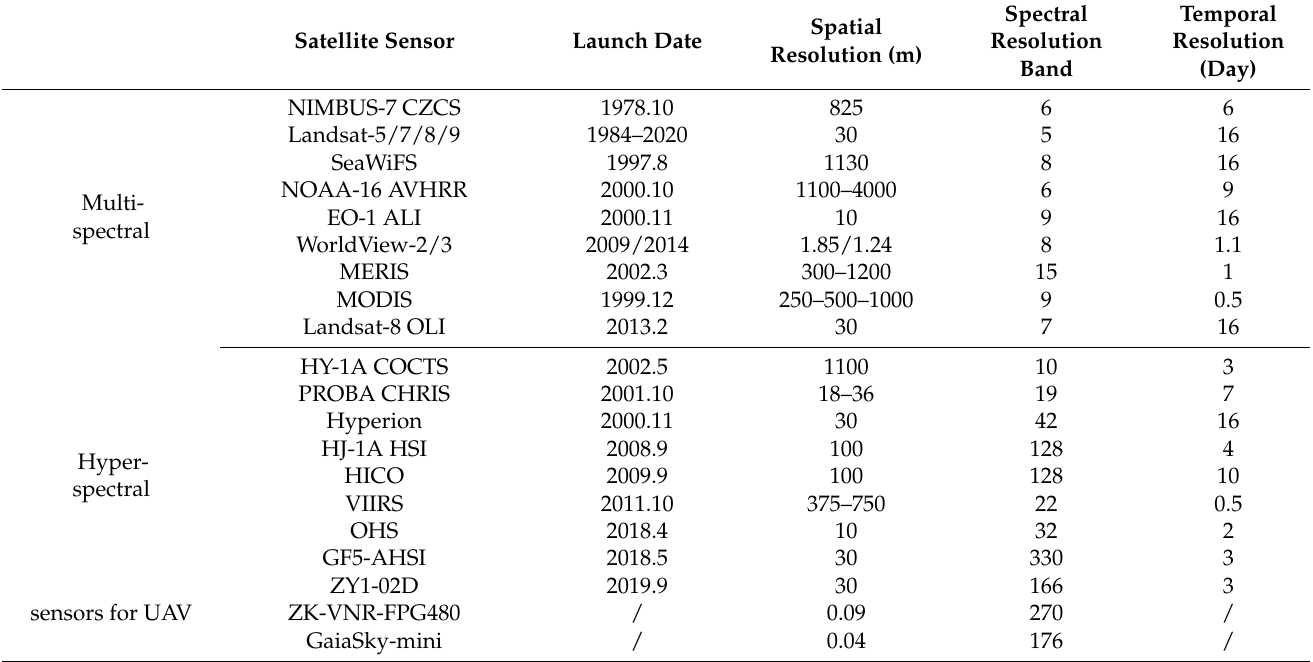
Table 1. Available satellites for remote sensing water quality retrieval (bands more than